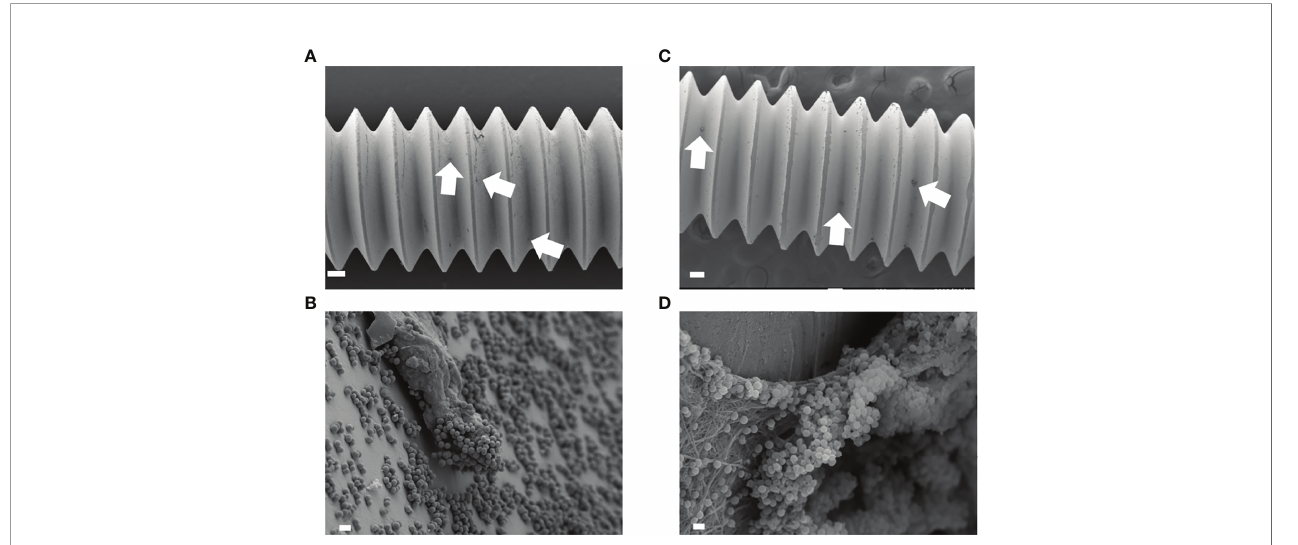
FIGURE 3 | Scanning electron microscopy (SEM) image of USA300LAC infected implant of in vitro day 1 (A, B) and in vivo day 3 (C, D) . In low magni fi cation images, a small amount of bio fi lm formations were observed (white arrow) (A, C) . White bars in A, C indicate 100 µm, and white bars in B, D indicate 1 µm.